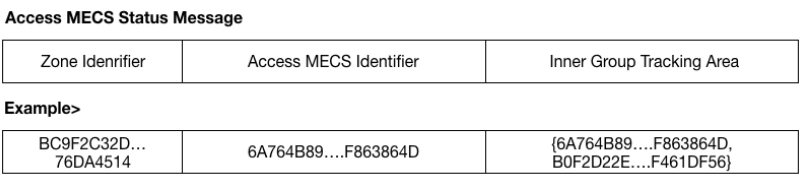
Figure 4. AMS message format and